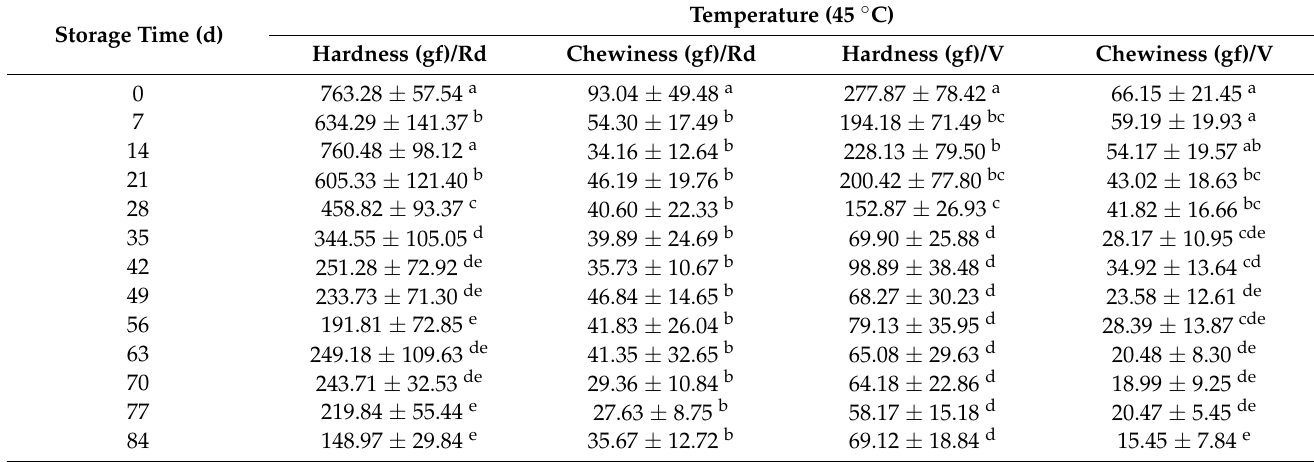
Table 1. Texture changes of Sichuan sauerkraut at different storage